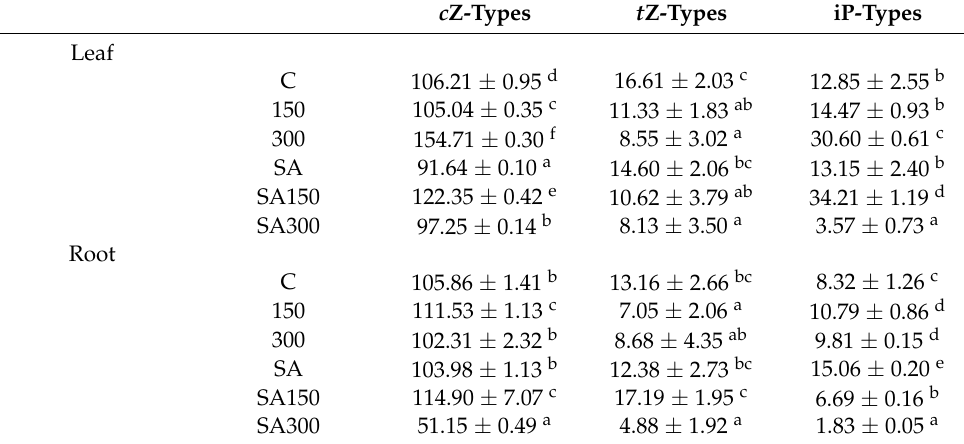
Table 3. Effect of salicylic acid (SA) pre-treatment on total cis -zeatin ( c Z), trans -zeatin ( t Z), and isopentenyladenine (iP) types of Hordeum vulgare L. ‘Ince-04 (cid:48) plant leaves and roots under control or saline conditions (150 and 300 mM NaCl). Values are mean ± SE ( n = 6). The data with different letters in the same column at superscript are significantly different ( p <